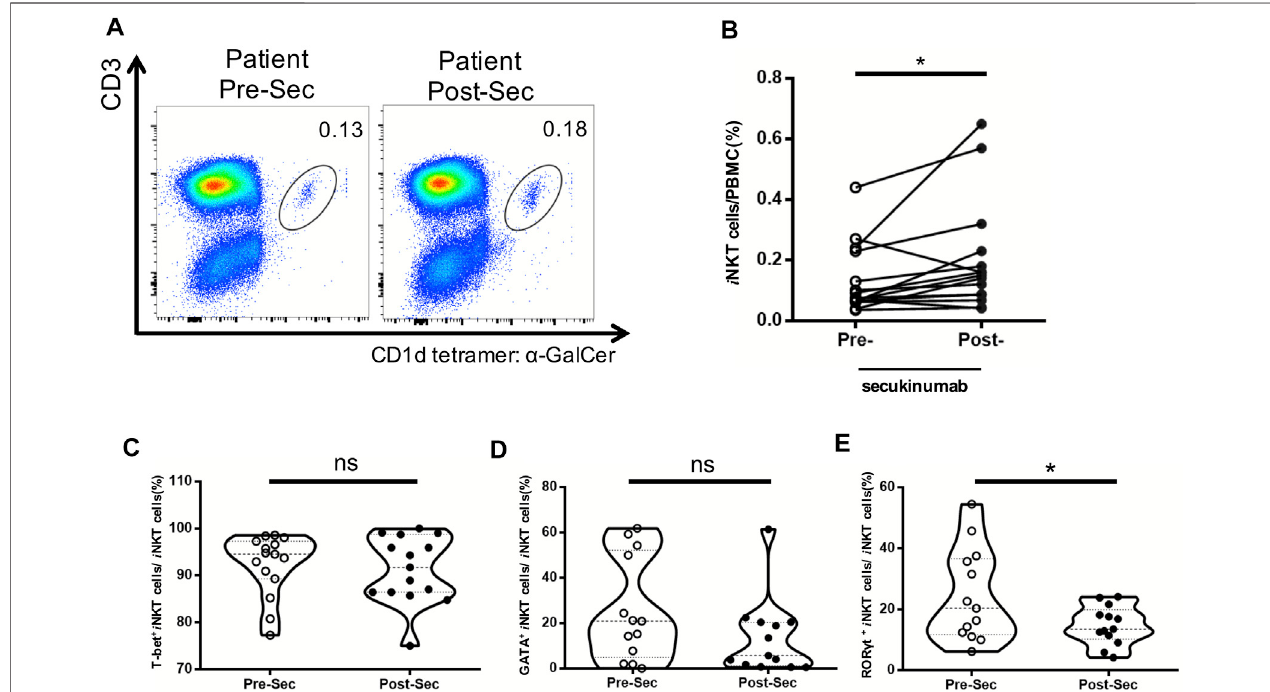
FIGURE 5 | Increased frequency of i NKT cells in psoriasis patients treated with secukinumab. PBMC were isolated from psoriasis patients (n (cid:1) 15) at baseline untreated (Week 0) and 12 Weeks post treatment with secukinumab. (A) Representative FACS dot plots for i NKT cells from psoriasis patients before and after secukinumab treatment versus healthy controls. (B) Summary plots showing individual results of i NKT cell frequency in psoriasis patients before and after secukinumab treatment. (C) SummaryplotsshowingindividualresultsofT-bet + i NKTcellsfrequencyinpsoriasispatientsbeforeandaftersecukinumabtreatment. (D) Summary plots showing individual results of GATA3 + i NKT cells frequency in psoriasis patients before and after secukinumab treatment. (E) Summary plots showing individual results ROR γ t + i NKT cells frequency in psoriasis patients before and after secukinumab treatment. Data show mean +SEM. p -values were determined by paired Student ’ s t-test. ns, no signi fi cance, * p < 0.05, ** p < 0.01, *** p < 0.001 and **** p < 0.0001.